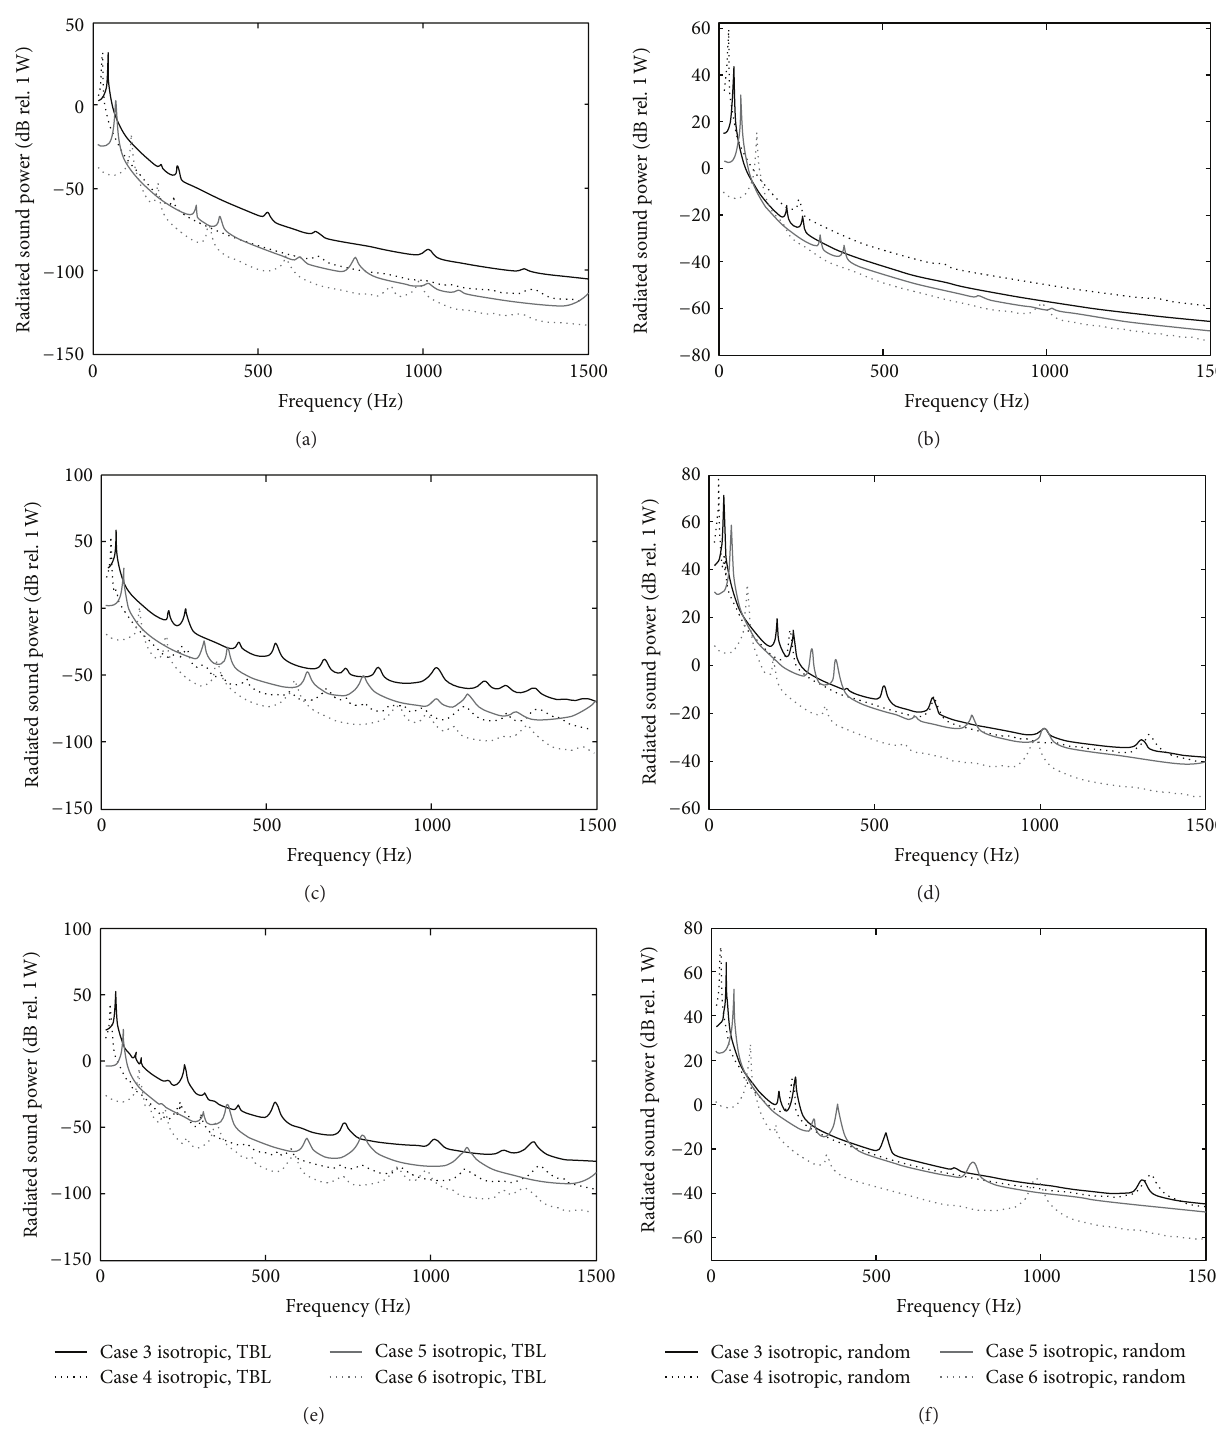
Figure 6: Radiated sound power results for the isotropic panels: (a) and (b) overall panel RSP; (c) and (d) RSP near surface location (𝑥 1 ,𝑦 1 ) = (0.5𝑎, 0.5𝑏) ; (e) and (f) RSP near location (𝑥